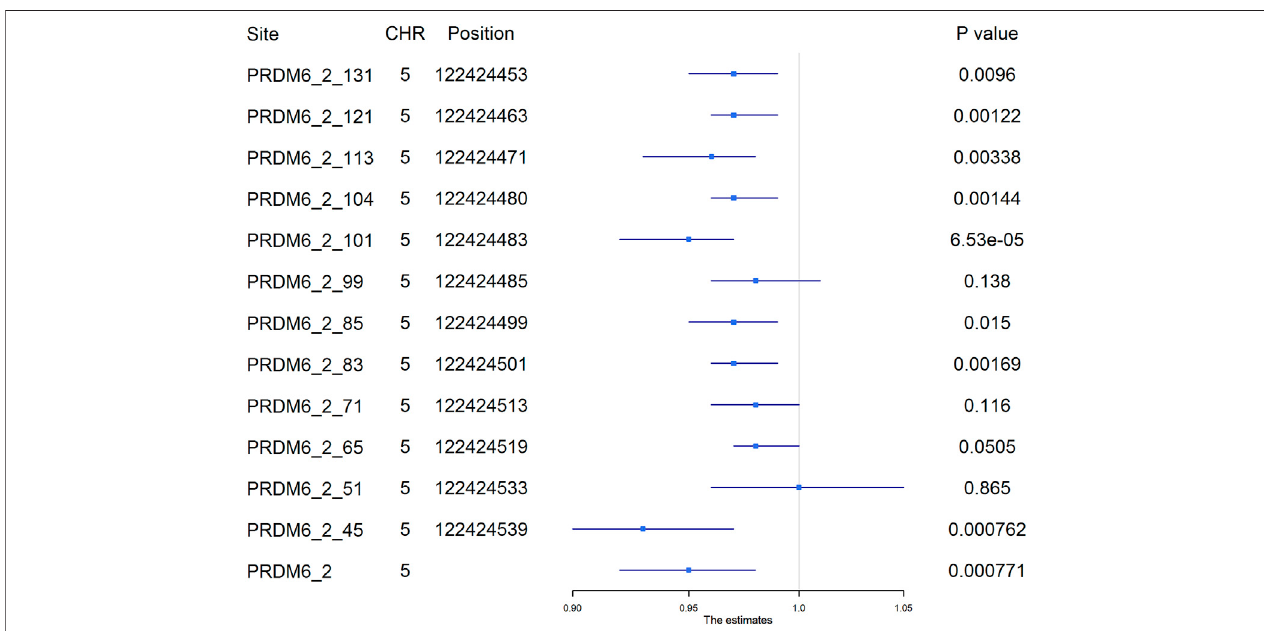
FIGURE 3 | The association between PRDM6_2 methylation and hypertension. The plot presented the ORs and the corresponding 95% CIs for the estimations of the effects of PRDM6 gene methylation on hypertension risk after adjusting for age, sex, smoking, drinking, body mass index, total cholesterol, and glucose. Methylationlevelsofeightsitesinthisgenewerenominallyassociatedwithhypertension(adjusted p < 0.05).Highmethylationlevelsinthesesiteswereassociatedwitha lower riskofhypertension. Thenamesofthemethylation siteswerede fi nedby “ genename_targetnumber_positionofthesite inthetarget ” .Thegenomicposition assembly was